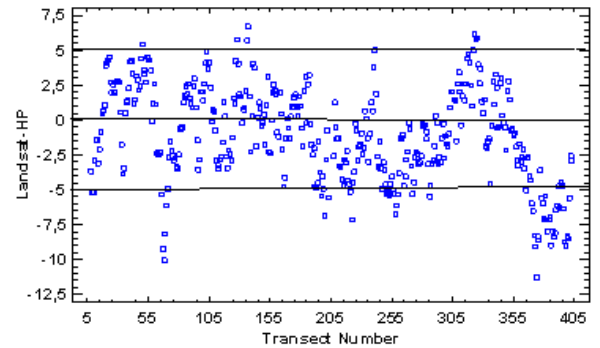
Figure 6. Plot of differences (in meters) between Landsat and HP averages versus the transect number during the period 2006-